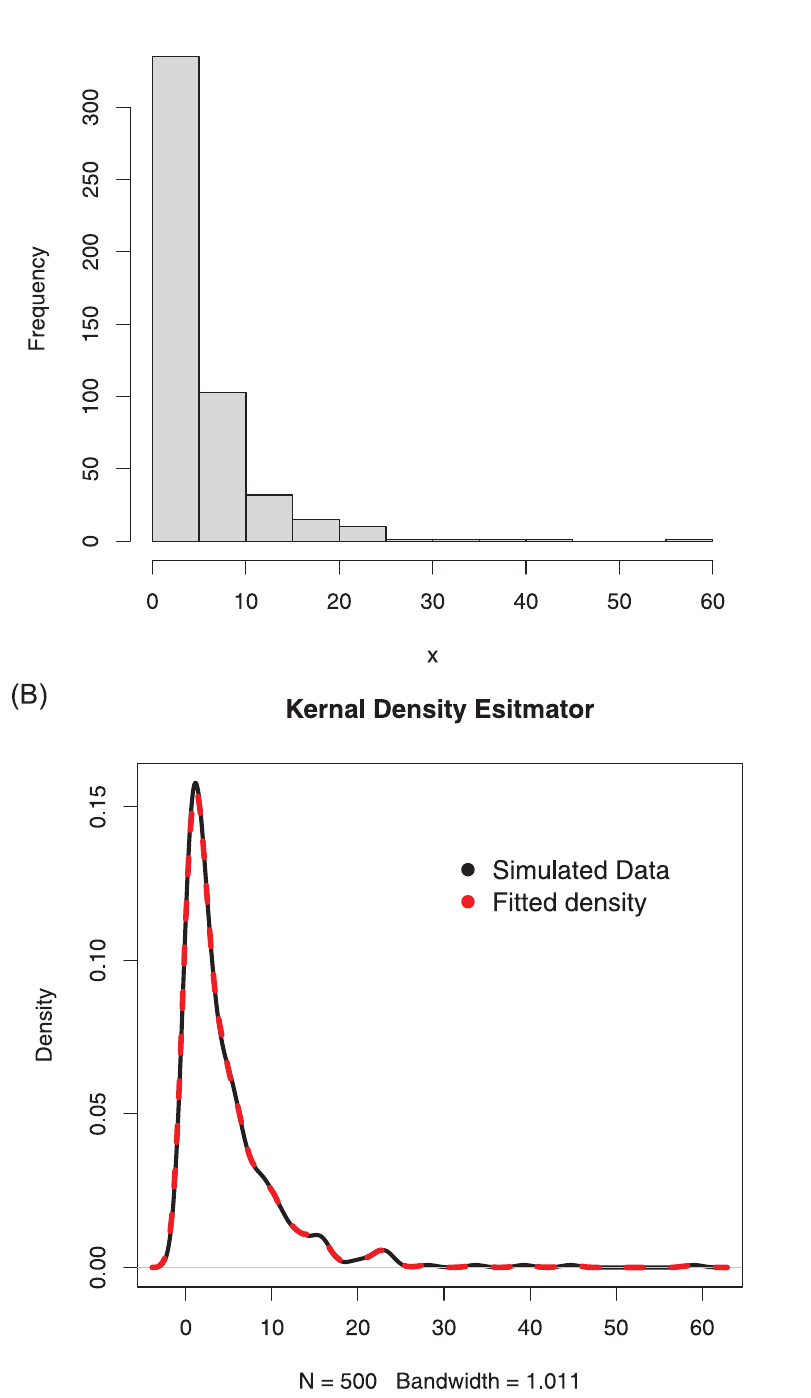
Fig 7. The histogram and Kernel density estimator of the simulated data set 1.